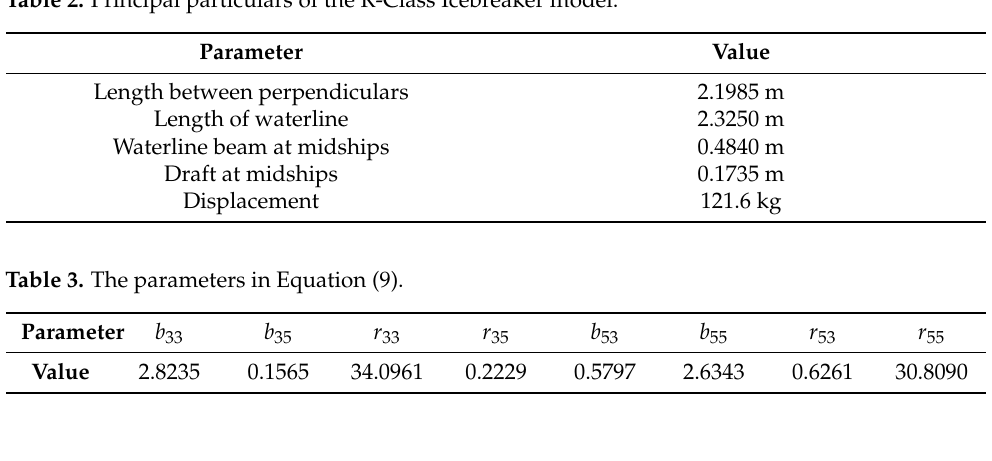
Table 2. Principal particulars of the R-Class Icebreaker model.